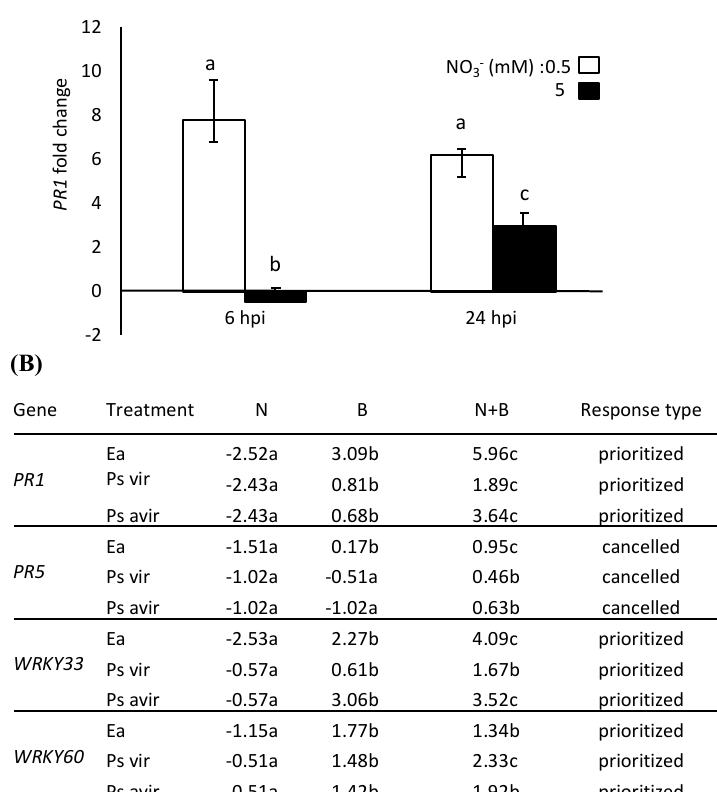
Figure 3. Impact of N supply on defense-related genes expression in response to different bacterial pathogens. ( A ) Time-course of PR1 gene expression at 6 and 24 hpi following mock or Ea treatment. ( B ) Response of selected defense-related genes in response to N, B, and N + B at 6 hpi. ( A , B ) Col-0 plants were grown in full (5 mM) or low (0.5 mM) NO 3 − . and infiltrated with bacteria ( Ea wild type, virulent and a virulent strain of P. syringae ) or mock-inoculated. Expression is normalized to the PP2a3 (At1g69960) constitutive gene. Values are log2 signal ratios between infected and mock plants. Similar results were obtained in a minimum of three independent experiments, including three biological replicates each; a representative experiment is shown. The bars represent standard deviation. ( A , B ): Different letters correspond to values that are significantly different according to the Mann–Whitney statistical test ( p -value <